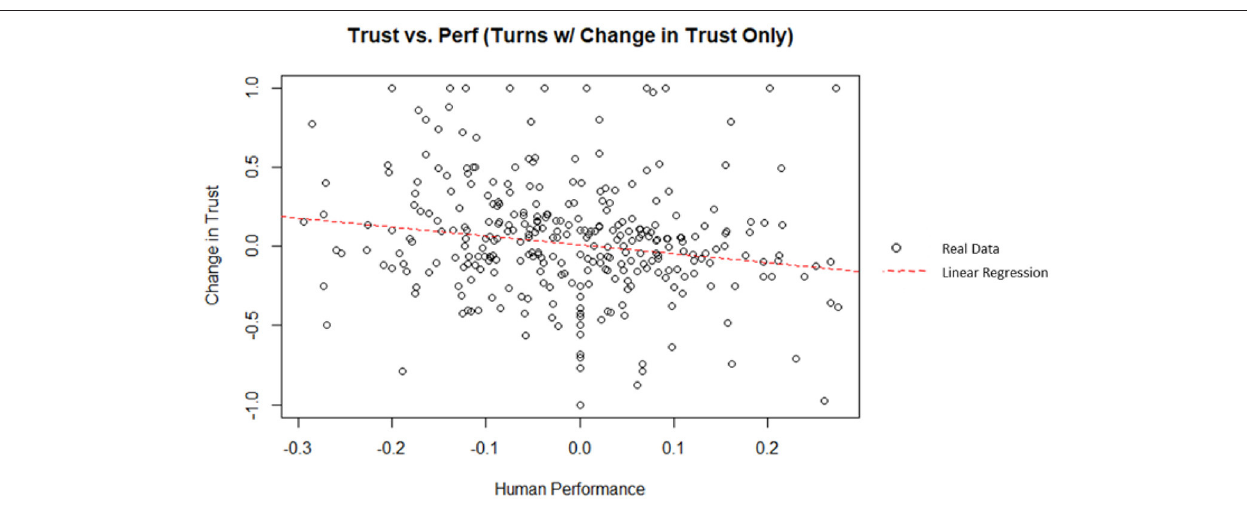
used to predict the change in trust from the previous turn from the difference in performance between the AI and the human. Difference in performance did explain a = 0.136). A plot of the data and 5.37 x 10 − 12 ; R 2 adjusted linear best fit line can be seen on Figure 12 . The